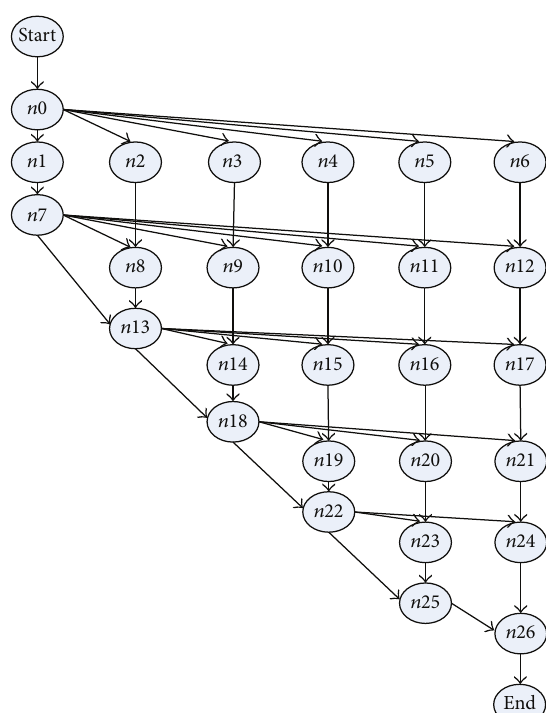
Figure 12: Gaussian elimination for a matrix of size 7.